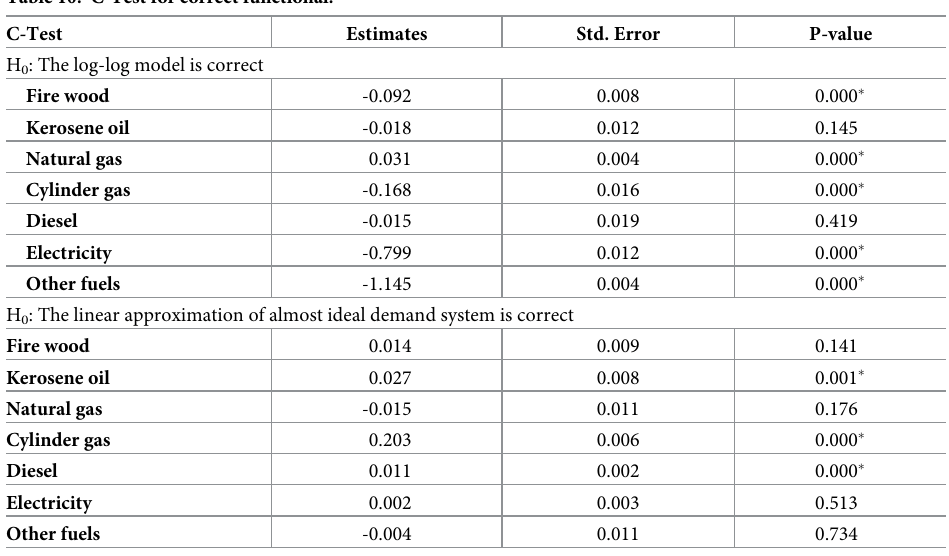
Table 10. C-Test for correct functional.